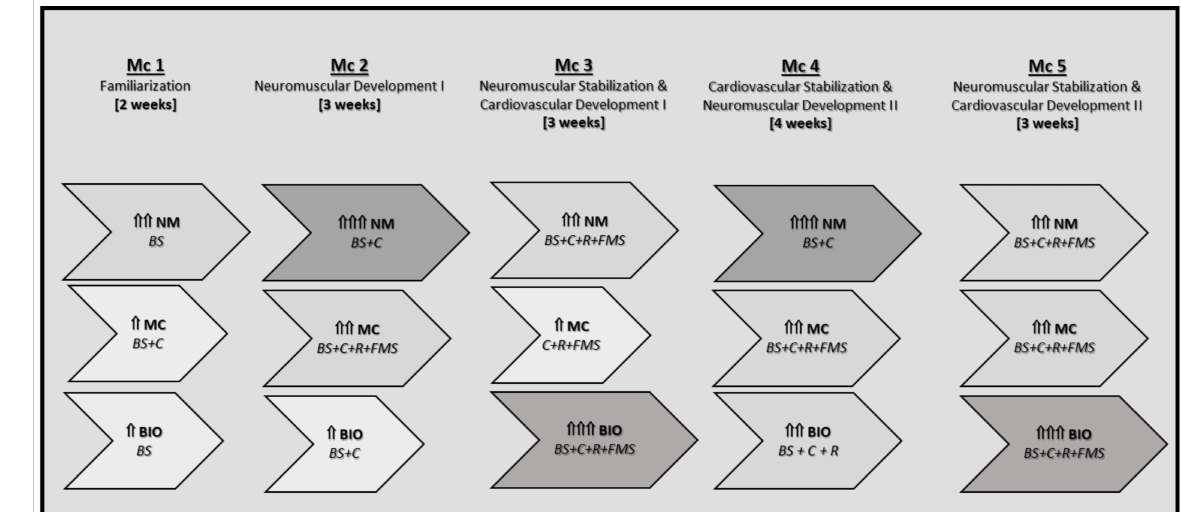
Figure 1. The EFAM-UV© periodization. Its six dimensions comprise two main basic skills (BS: gait training and postural control) plus two complementary skills (C: manipulative and cognitive) at a first level. In a second level of the EFAM-UV© taxonomy there are the rhythm tasks (R) and functional motor skills (FMS). Horizontal arrows represent the strain in each domain and the contents’ orientation (NM: neuromuscular; MC: motor control; BIO: bioenergetics). The length and vertical small arrows (and color hues) reflect the prevalence and importance of each motor domain (see Ref. [44] for a deep description of this